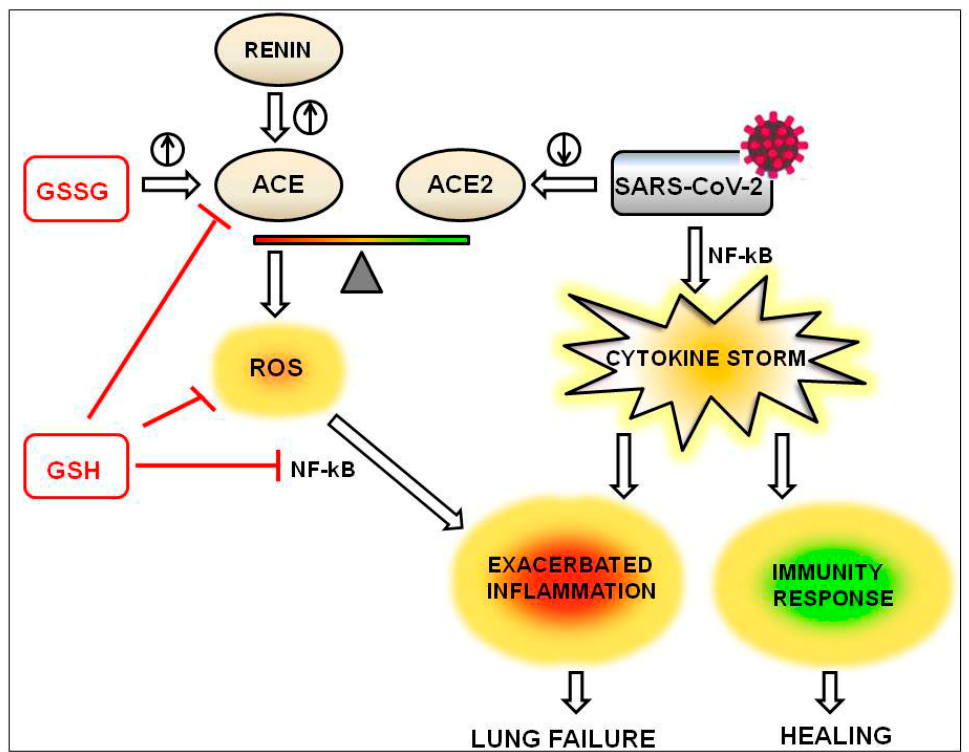
Figure 2. The anti-inflammatory effects of reduced glutathione (GSH) are exerted through the inhibition of ACE activity, decrease of reactive oxygen species (ROS) production and reduction of NF-kB activation (red lines). The balance ACE/ACE2 is shifted toward ACE by the oxidized form of glutathione (GSSG) and by renin (the circled arrows pointing upwards indicate the induction of ACE) and by viral infection (the circled arrow pointing downwards indicates the downregulation of ACE2).